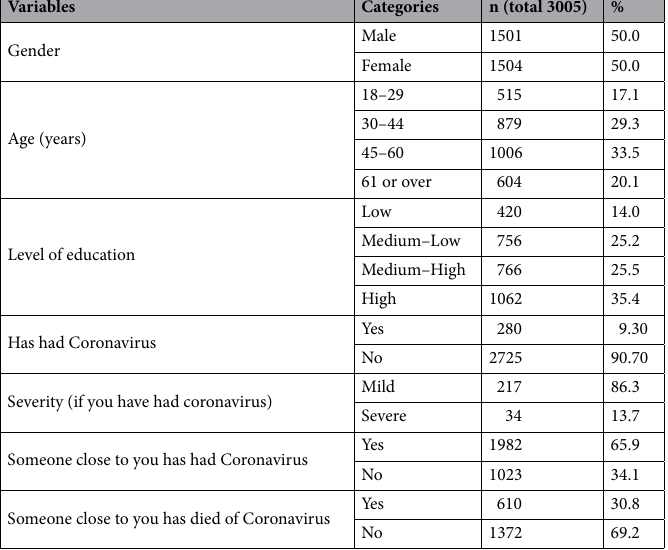
Table 2. Descriptive socio-demographic variables.